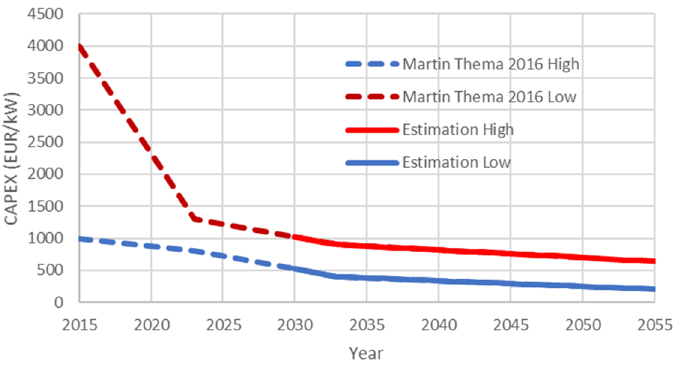
Figure 6. CAPEX for PtG system from 2020 to 2050.